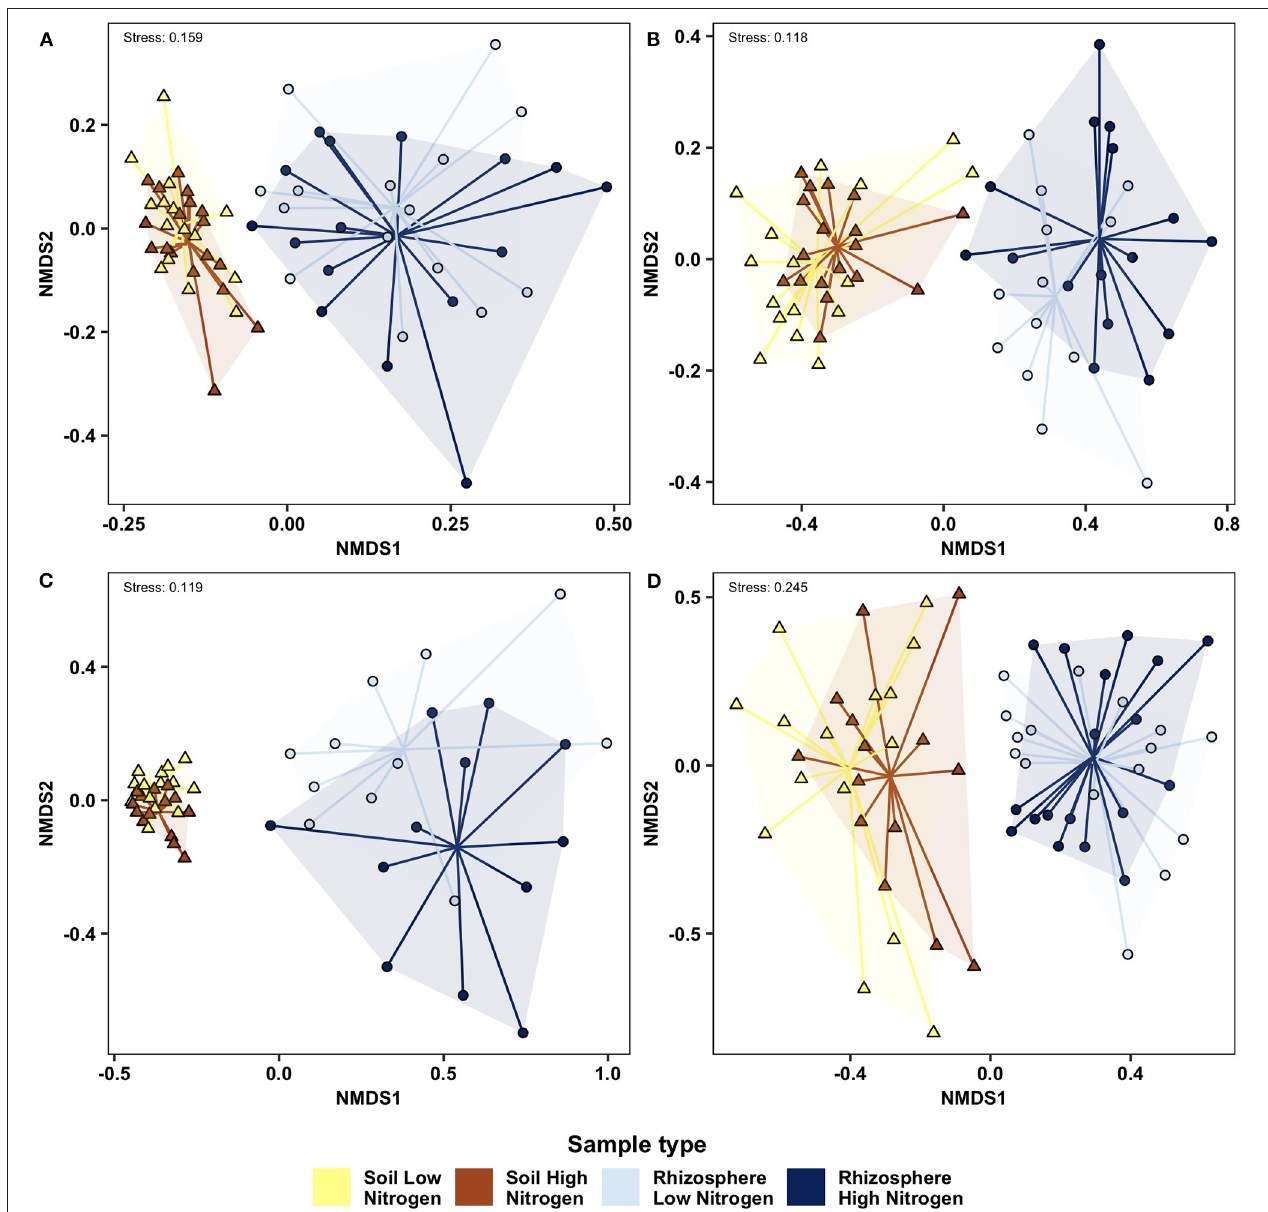
FIGURE 2 | Non-metric multidimensional scaling analysis of soil and rhizosphere microbial communities determined using Bray Curtis similarity analysis of high and low nitrogen treatments, with data for each treatment reflecting combined data from 10 oilseed rape genotypes. (A) Bacteria; (B) Fungi; (C) Protist; (D) Nematode. Samples from each compartment/ nitrogen treatment combination are connected to a group centroid inside colored segments. 1 , soil; o,